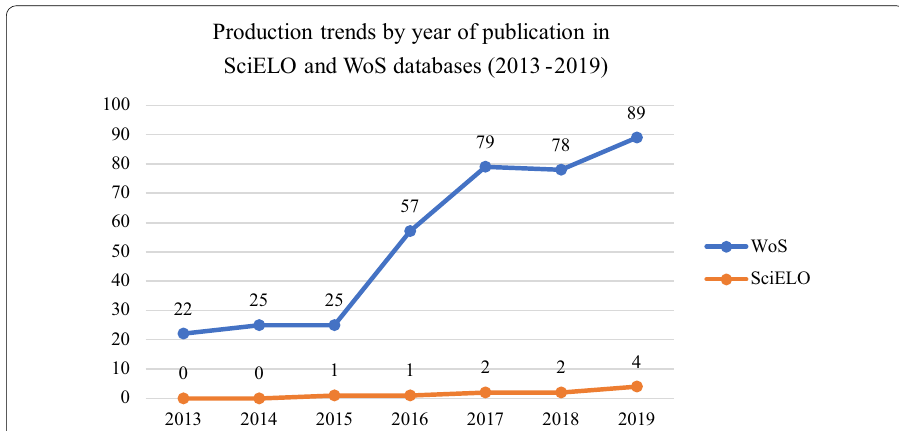
Fig. 1 Number of publications per year in WoScc and SciELO databases between 2013‑2019. Own